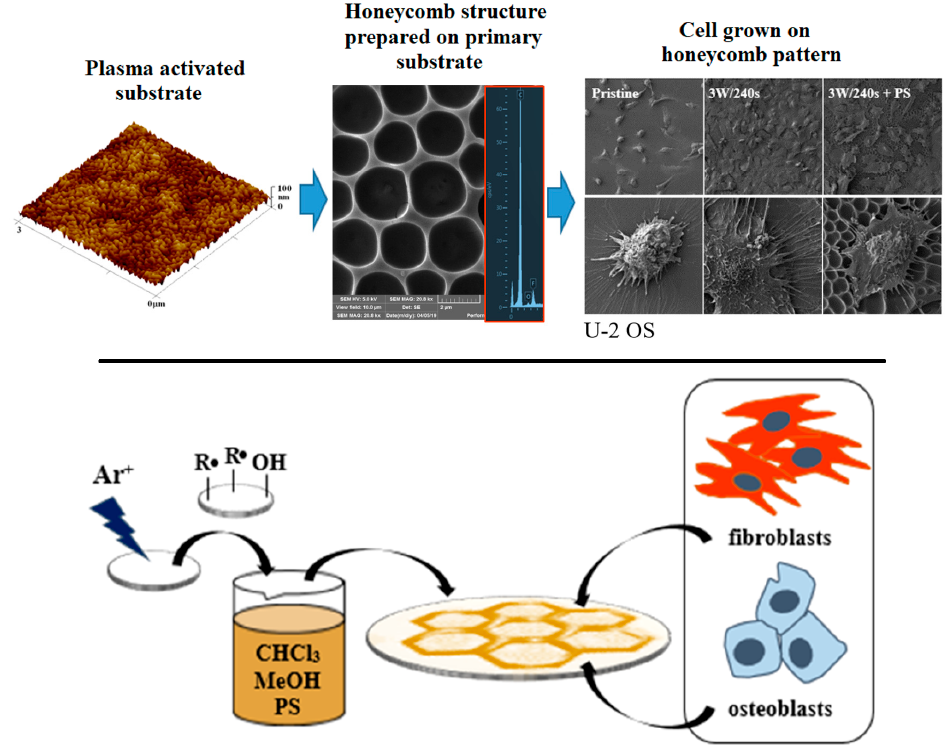
Figure 6. Scheme of the preparation of a polymer scaffold for cell culture [27].